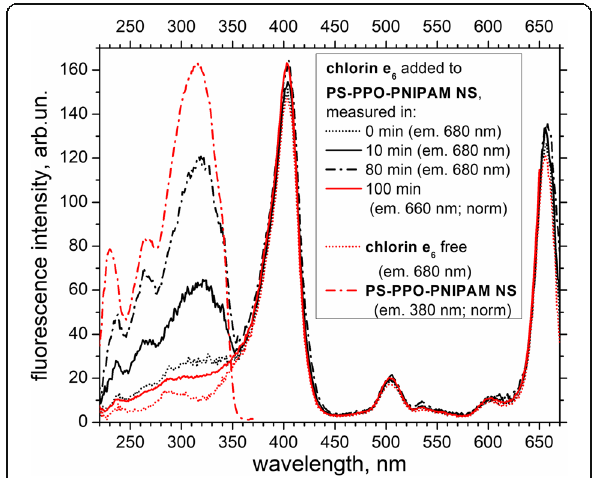
Fig. 7 Fluorescence excitation spectra of chlorin e 6 free and added to PS-PPO-PNIPAM hybrid NS (measured in 0, 10, 80, and 100 min after addition), and PS-PPO-PNIPAM hybrid NS itself. Emission wavelengths for chlorin e 6 are 660 nm (normalized intensity) and 680 nm. Emission wavelength for PS-PPO-PNIPAM NS is 380 nm (normalized intensity).